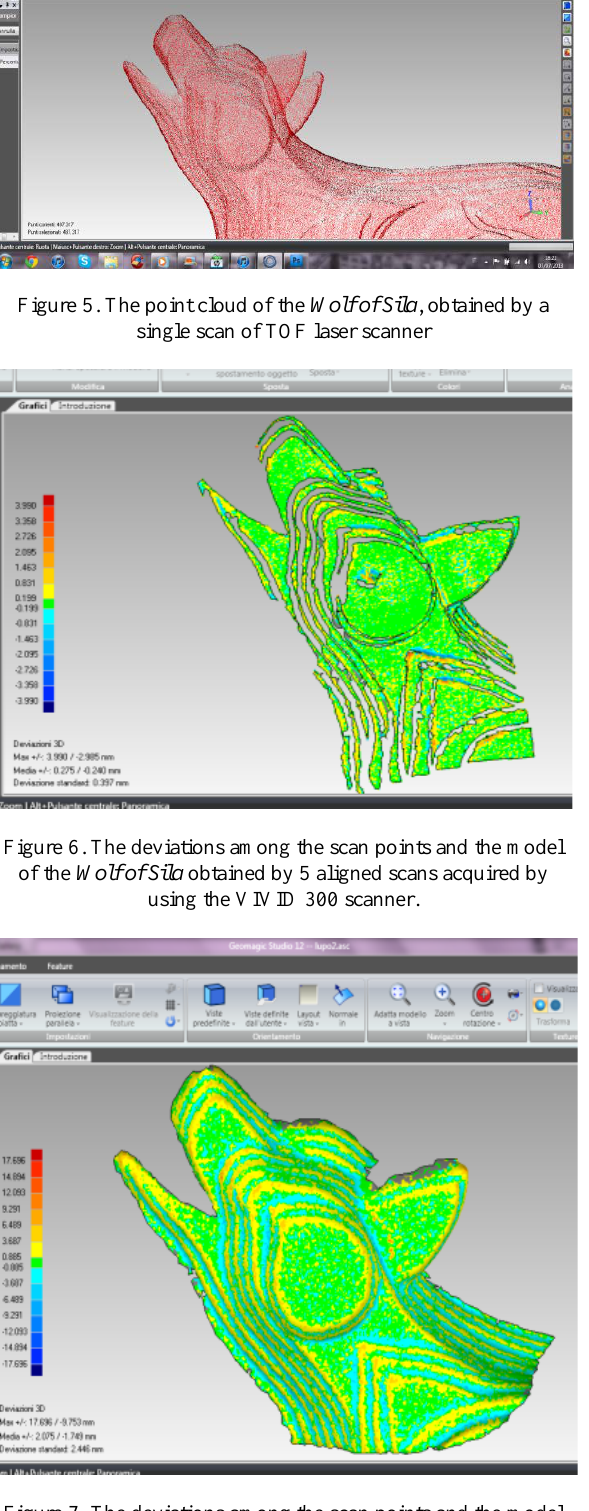
Figure 7. The deviations among the scan points and the model of the Wolf of Sila obtained a single scan acquired by using the Leica C10 ToF laser scanner.